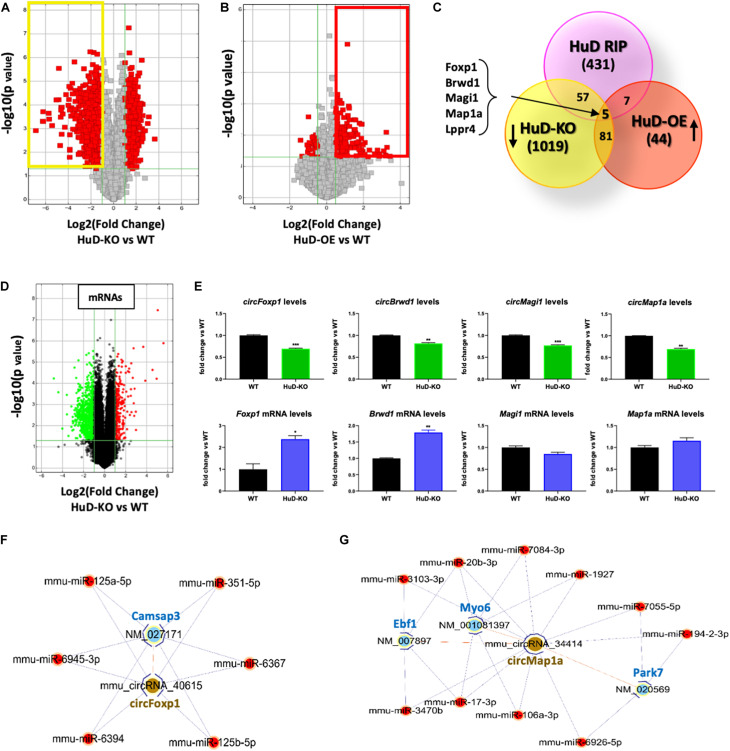
Profiling of circRNA expression changes in HuD-OE and HuD-KO mice. (A) Volcano plots representing circRNAs differentially expressed between HuD-KO (Elavl4–/–) mice and WT littermates. The vertical lines correspond to 2-fold change up and down, respectively, and the horizontal line represents a p-value of 0.05. Values shown in red represent the differentially expressed circRNAs. n = 3 for each genotype (HuD-KO, WT). (B) Volcano Plots representing circRNAs differentially expressed between HuD-OE mice and WT littermates. RNA extracted from HuD-OE and WT mouse striatum was subjected to circRNA array as described in Methods. The vertical lines correspond to 1.5-fold change up and down, respectively, and the horizontal line represents a p-value of 0.05. Values shown in red represent the differentially expressed circRNAs. n = 3 for each genotype (HuD-OE, WT) (C) Identification of common elements between circRNAs bound to HuD and circRNAs whose expression is regulated by HuD. A list of 5 candidate HuD circRNAs for validation was obtained comparing the results of the three different arrays. (D,E) Comparison of circular and linear RNA levels. (D) RNA extracted from HuD-KO and WT mice striatum was subjected to mRNA microarray analysis as described in section “Materials and Methods.” The vertical lines in the volcano plot correspond to 2-fold change up or down, respectively, and the horizontal line represents a p-value of 0.05. Values shown in red or green represent the differentially up- and down-regulated mRNAs. n = 3 for each genotype. (HuD-KO, WT). (E) Graphs showing levels of both circular (top) and linear (bottom) RNA levels in HuD-KO mice vs. WT. Data are Means ± SEM, *p < 0.05, Student’s t-test. (F,G) ceRNA networks. ceRNA analyses were performed as described in sction “Materials and Methods.” circRNA/miRNA/mRNA networks were generated to visualize the interactions for circFoxp1 and circMap1; the ceRNAs of the remaining circRNAs are reported in Supplementary Table 3.